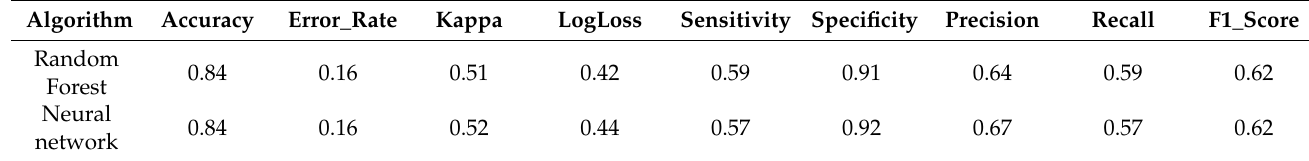
Table 14. Models for city of